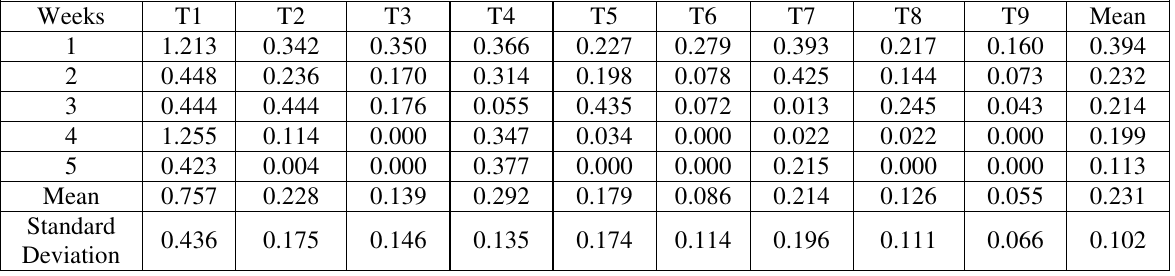
TABLE 3. EFFECT OF SELECTED PHCS ON THE WET-BIOMASS (gL -1 DAY -1 ) OF ALGAL BIOFILMS GROWING IN THE BG11 MEDIA AS GROWTH MEDIUM